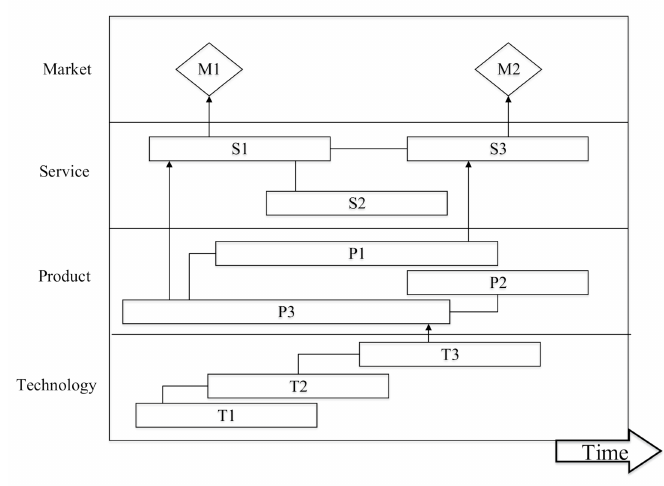
Figure 1. Structure of a technology